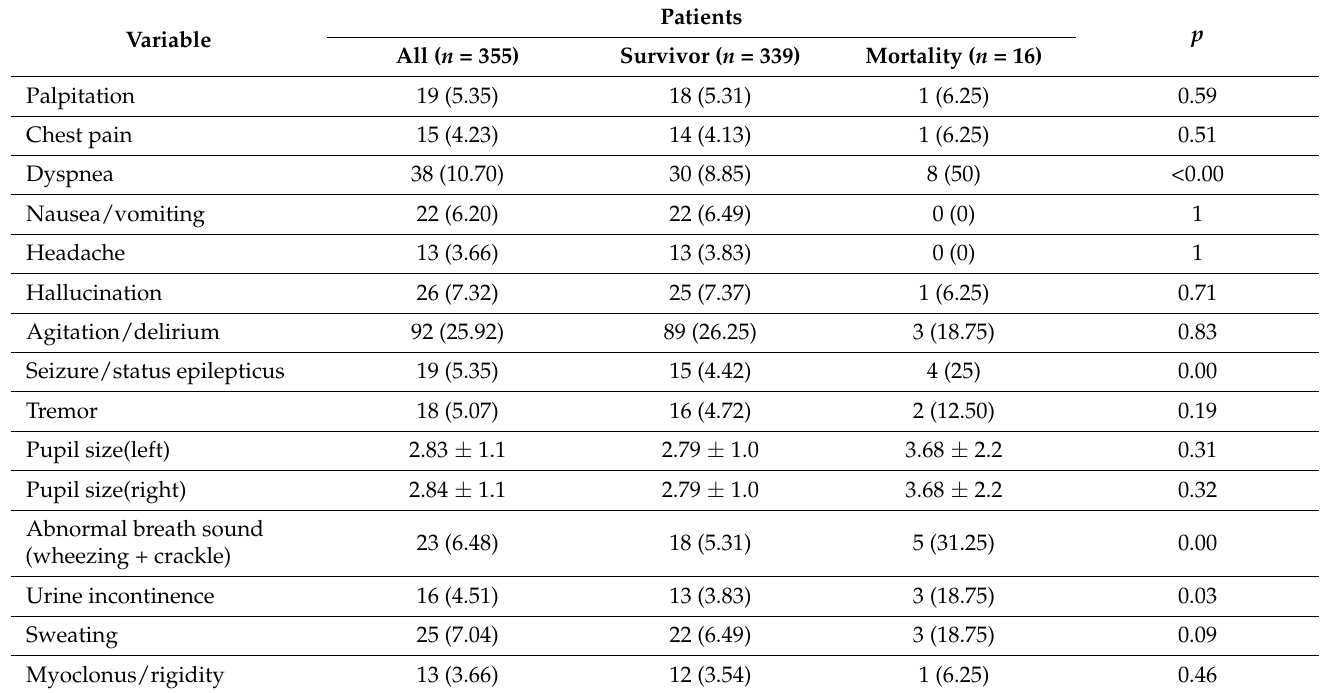
Table 3. Clinical presentations of the illicit drug users on arrival at the ED of survivors and mortality